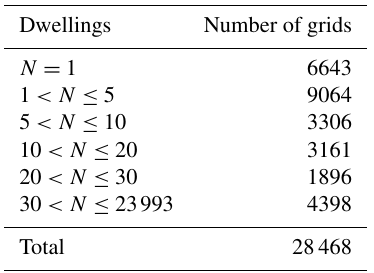
Table 1. Number of dwellings sampled by grid cells of 10km × 10km in the study